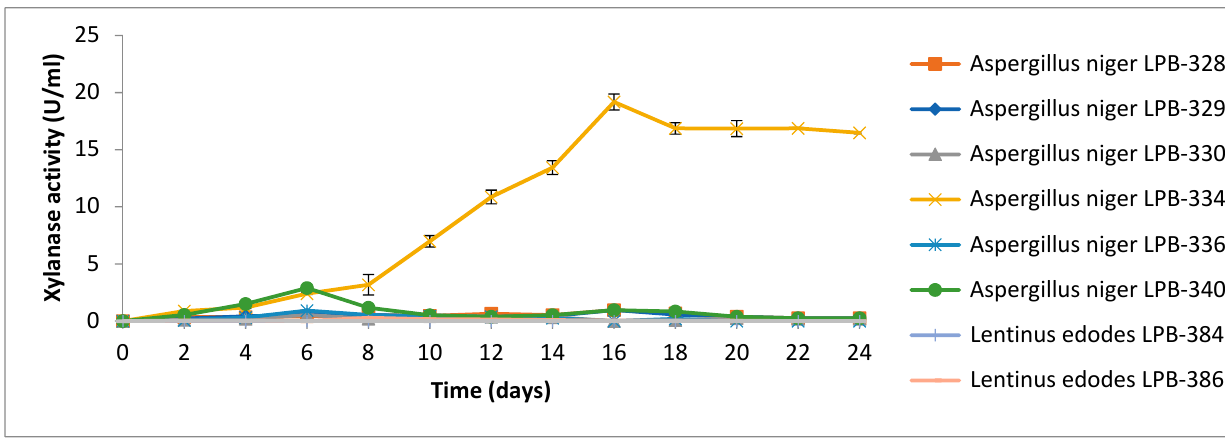
Figure 2. Time course of cellulase activity production in liquid culture by Aspergillus niger strains. The error bars represent standard deviations. The averages of results of three independent experiments, each one performed with three biological replicates, are reported.